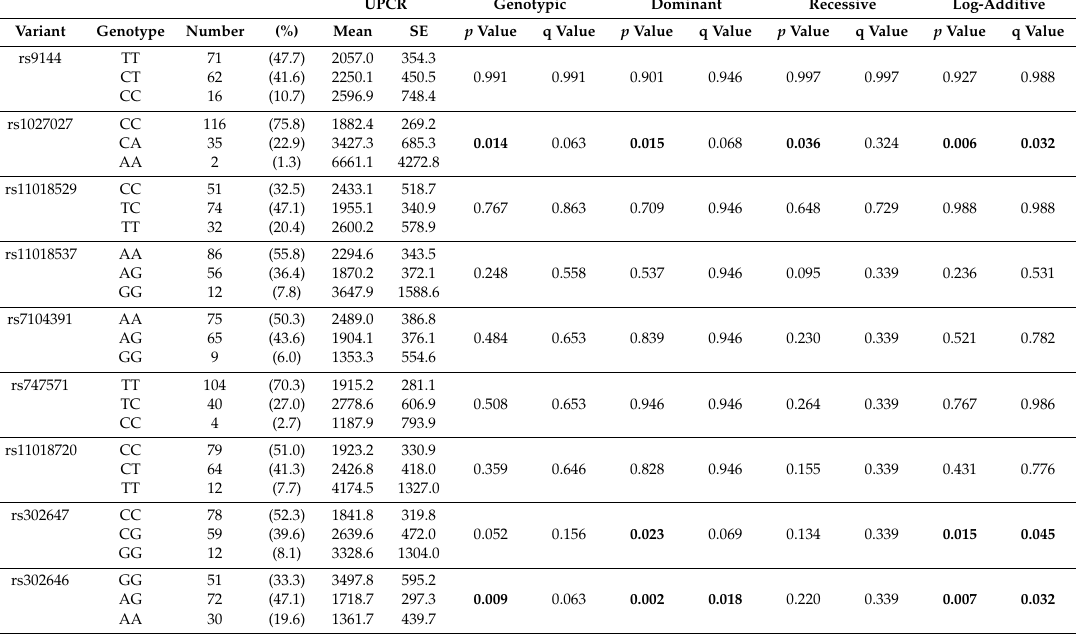
Table 4. Association analysis between RAB38 single-nucleotide polymorphisms (SNPs) and the urine protein and creatinine ratio (UPCR) in the male